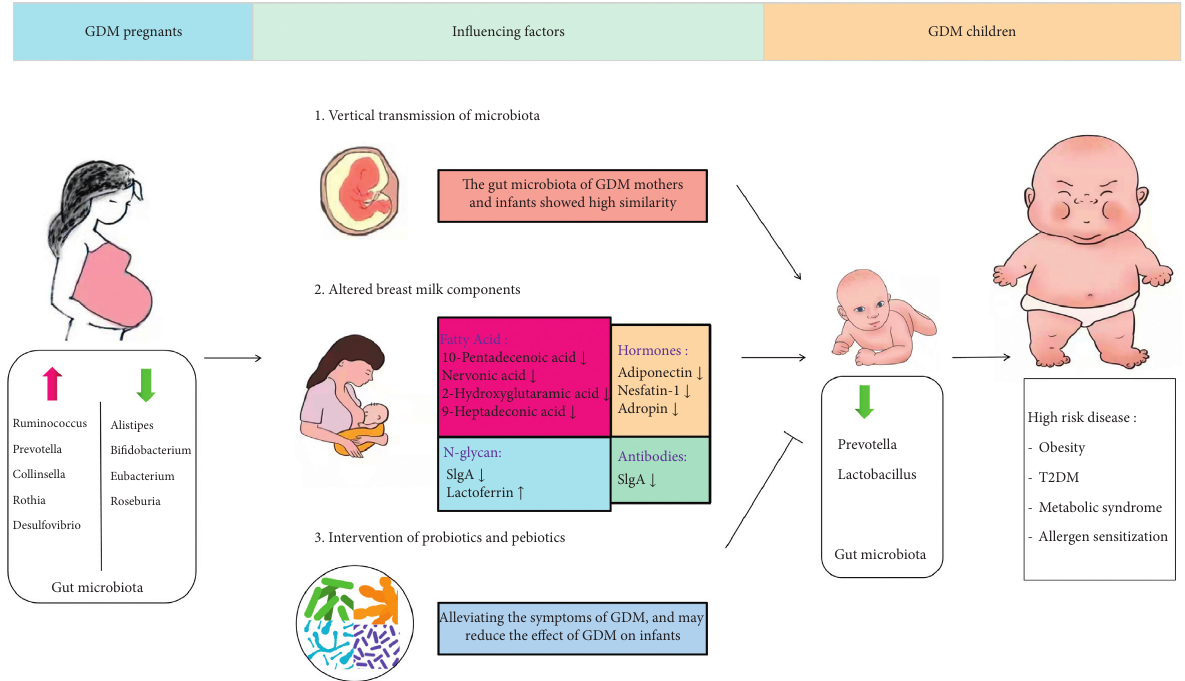
Figure 1: GDM mothers influence the gut microbiota of infants in different